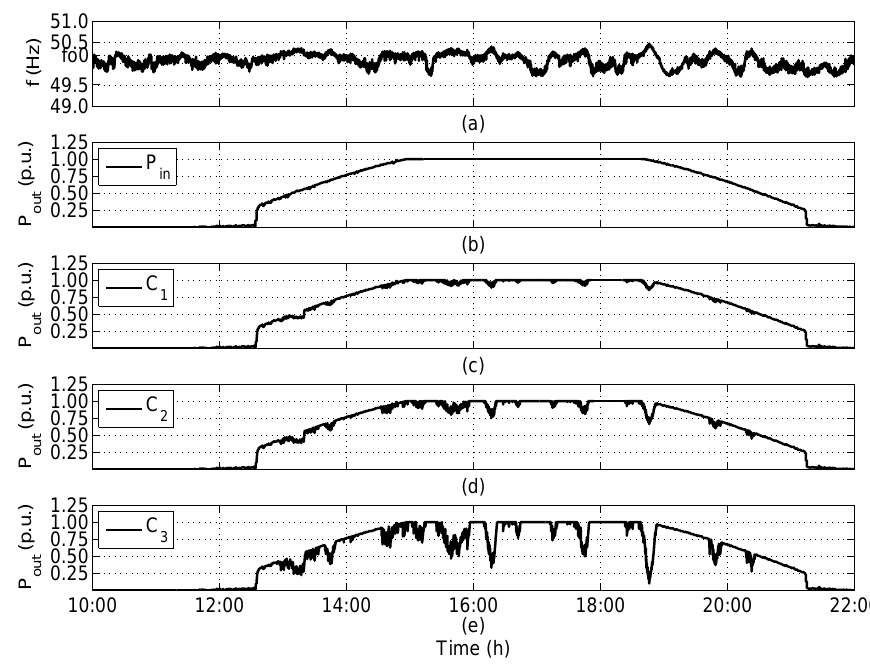
Figure 13. USPVP active power output ( P out ) and frequency in 15th October in Chile: ( a ) Registered frequency; ( b ) Ideal USPVP active power output ( P in ); and ( c , d and e ) power output applying FR with f 1 = { C 1 , C 2 , C 3 } = { 52,51,50.5 } Hz respectively.